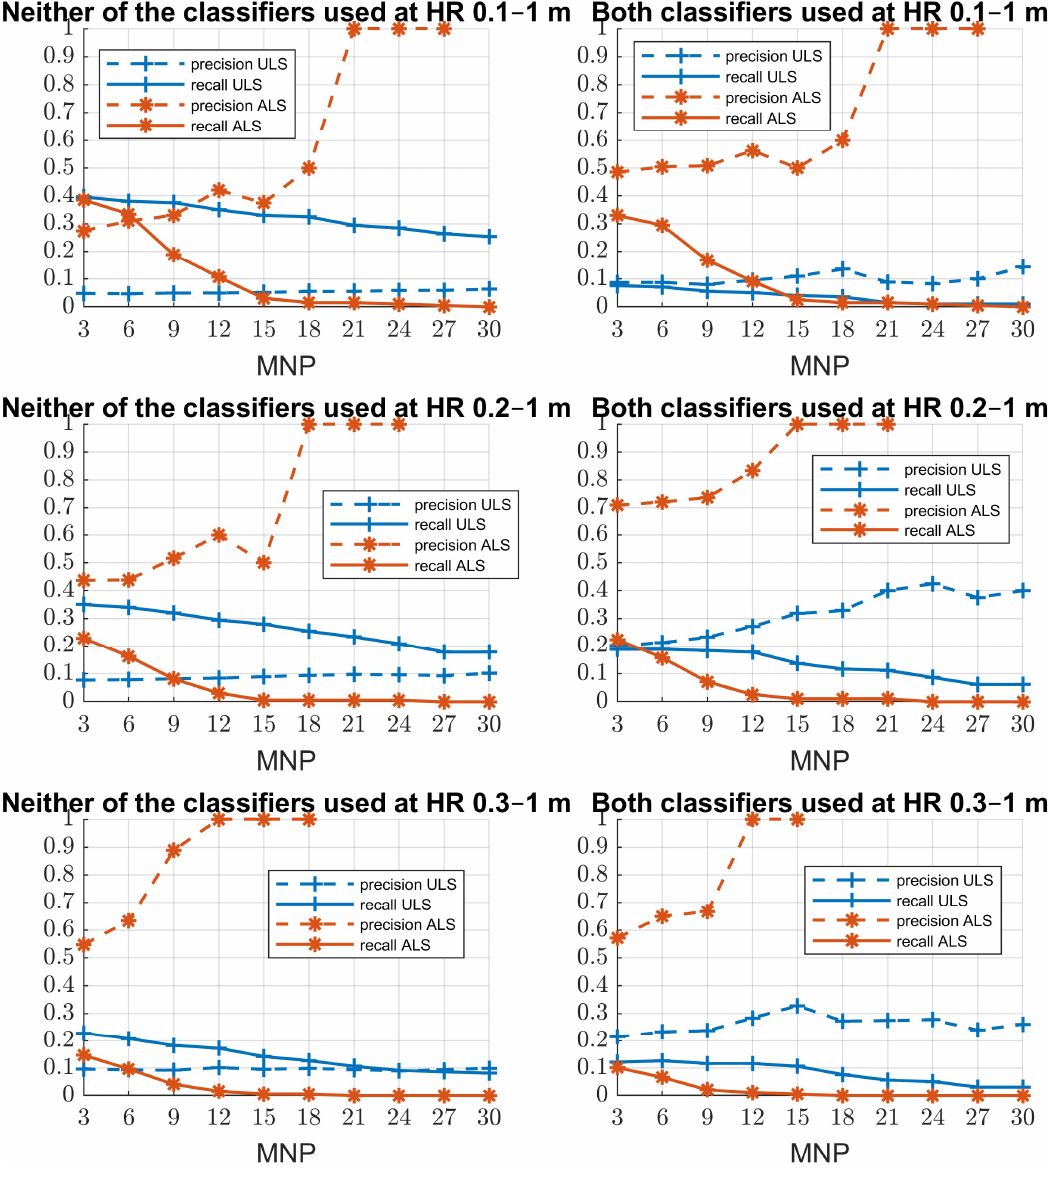
Figure 4. The precision and recall of the fallen tree method on the ALS and ULS datasets at different height ranges when the connected component classifier and the false tree remover were not used ( left ) and when both of these classifiers were used ( right ). MNP denotes the minimum number of points parameter.